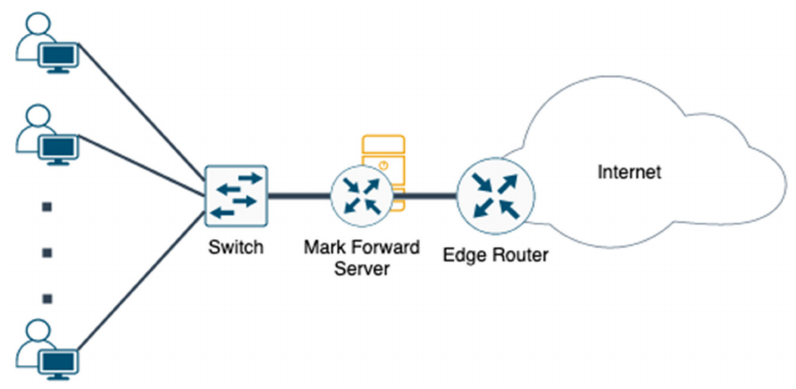
Figure 11. Architecture of traffic classification system.